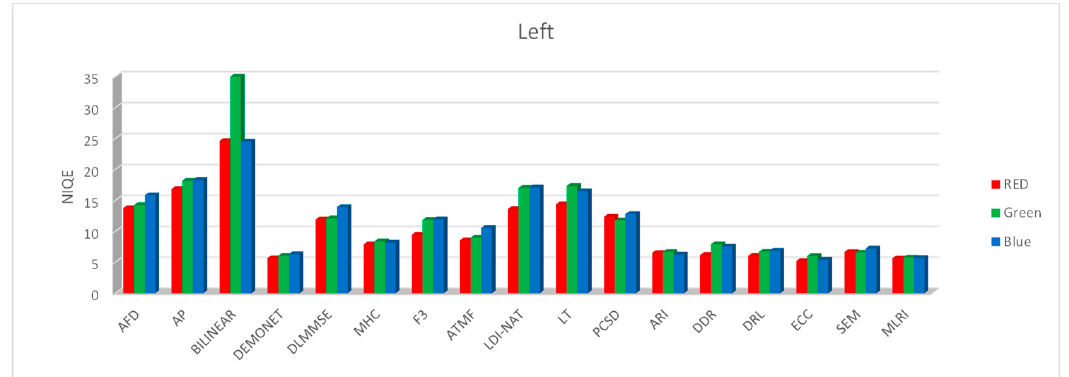
Figure 4. Averaged NIQE scores of different bands for left images using all methods.